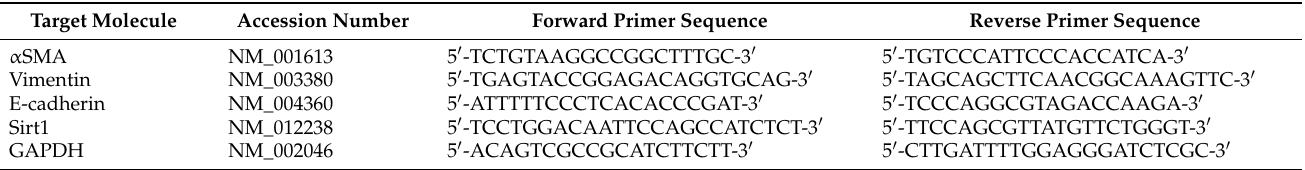
Table 1. Primer Sequences Used for Real-Time